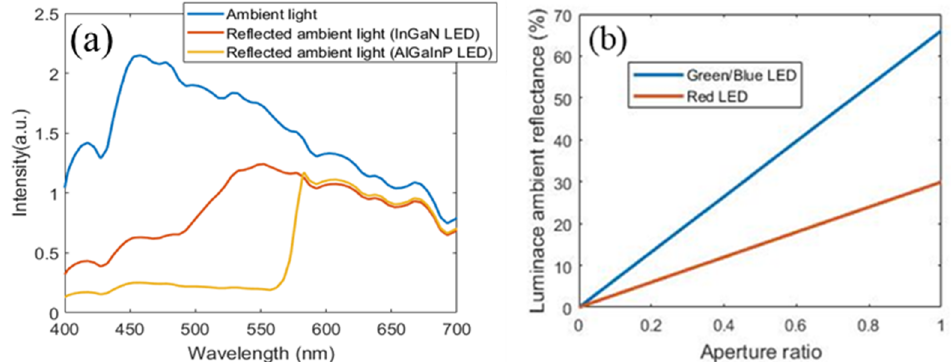
Figure 2. ( a ) The intensity spectrum of ambient light, ambient light reflected by AlGaInP based LED, and ambient light reflected by InGaN based LED. ( b ) The luminance ambient reflectance of RGB micro-LEDs at different LED chip aperture ratio.